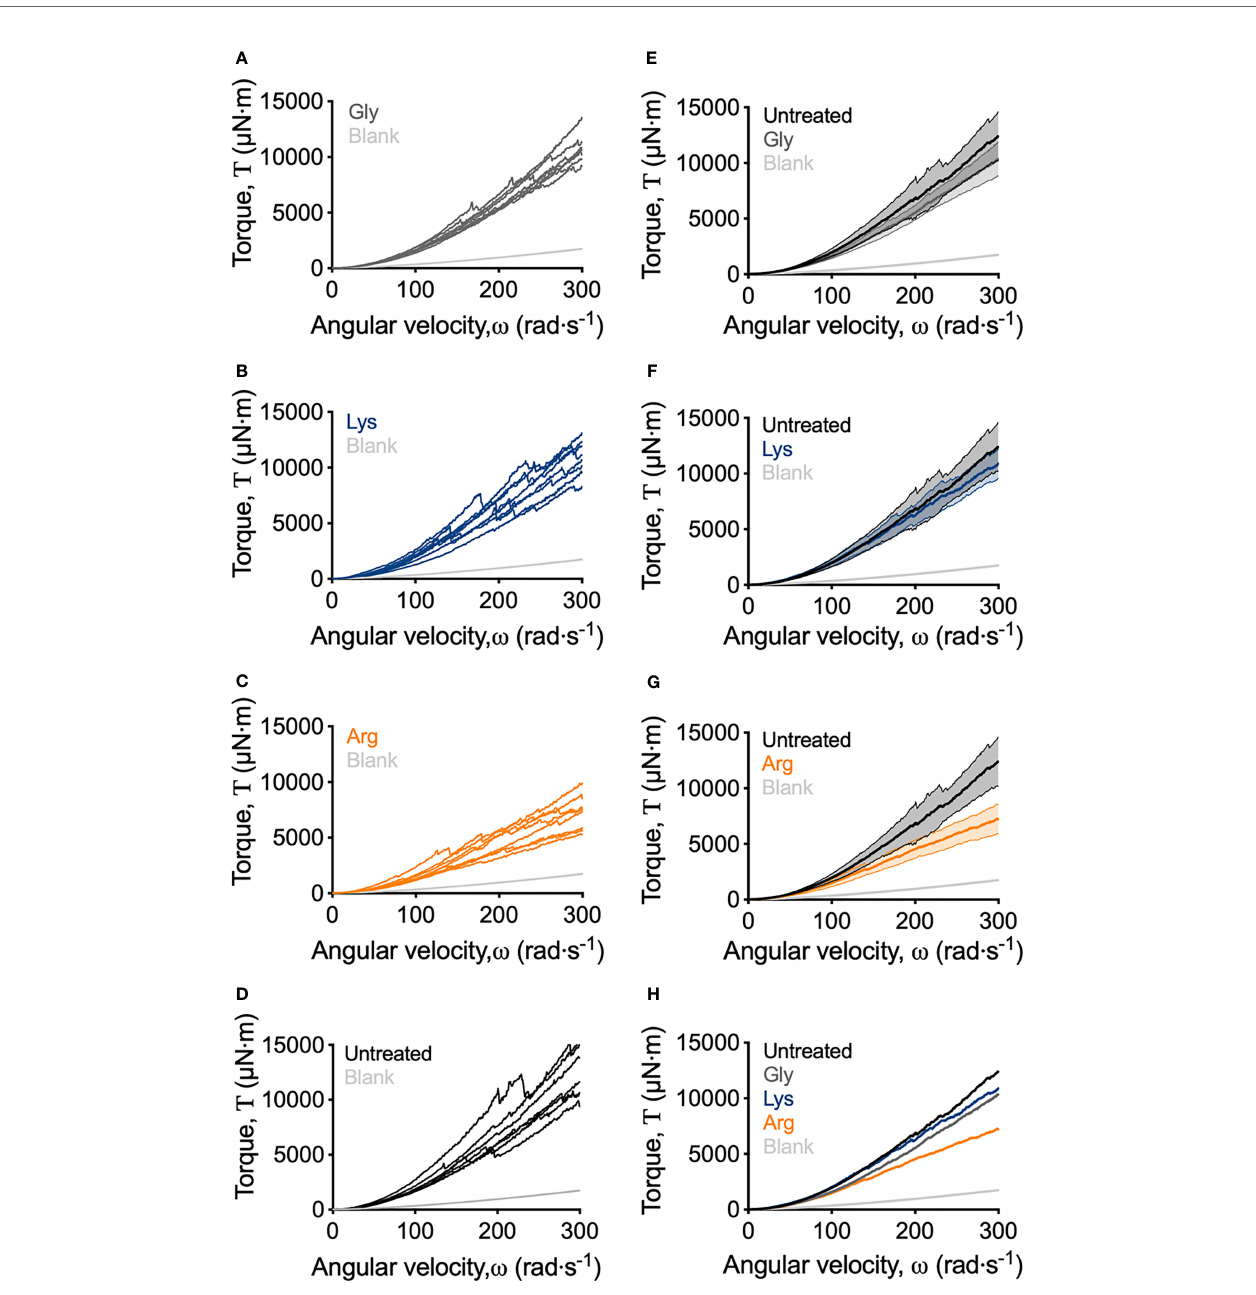
FIGURE 3 | Adapted rotating-disc measurements of untreated and amino acid treated S. gordonii bio fi lms. (A – D) Torque – displacement curves of individual replicates of glycine-, lysine-, arginine-treated and untreated (labelled) S. gordonii bio fi lms. (E – G) Comparison of the torque – displacement pro fi les of glycine-, lysine- and arginine-treated bio fi lms to untreated bio fi lms (labelled). Data is presented as mean ± 95% con fi dence interval. (H) Data from (A – D) expressed as mean. Replicate graph with data presented as mean ± 95% con fi dence interval is depicted in Figure S3 . In each panel, blank indicates analysis for coupon alone, with no bio fi lm. 4 biological replicates were performed, with 2 bio fi lms analyzed for each replicate (total N =